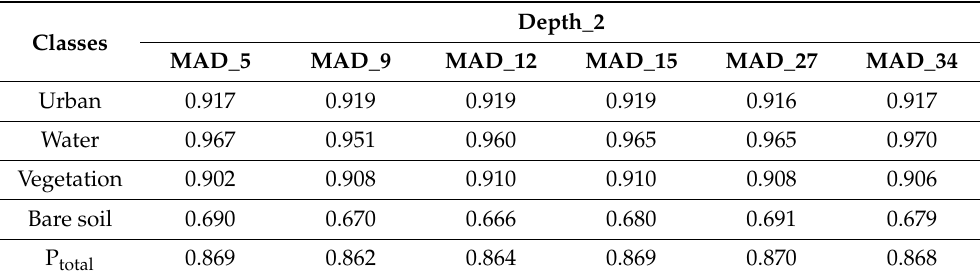
Table 7. Probabilities for classes and total probabilities of correct classification for depth 2 and different MAD.